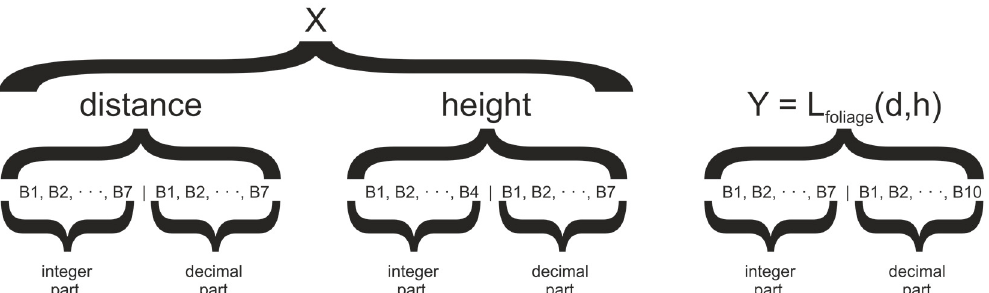
Figure 3. Schematic of the Deep Learning Model for the estimation of attenuation from distance and height.